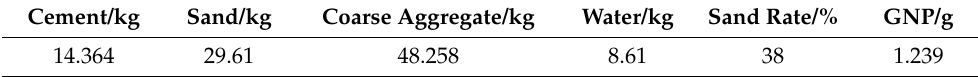
Table 2. Graphene concrete mix proportion design.